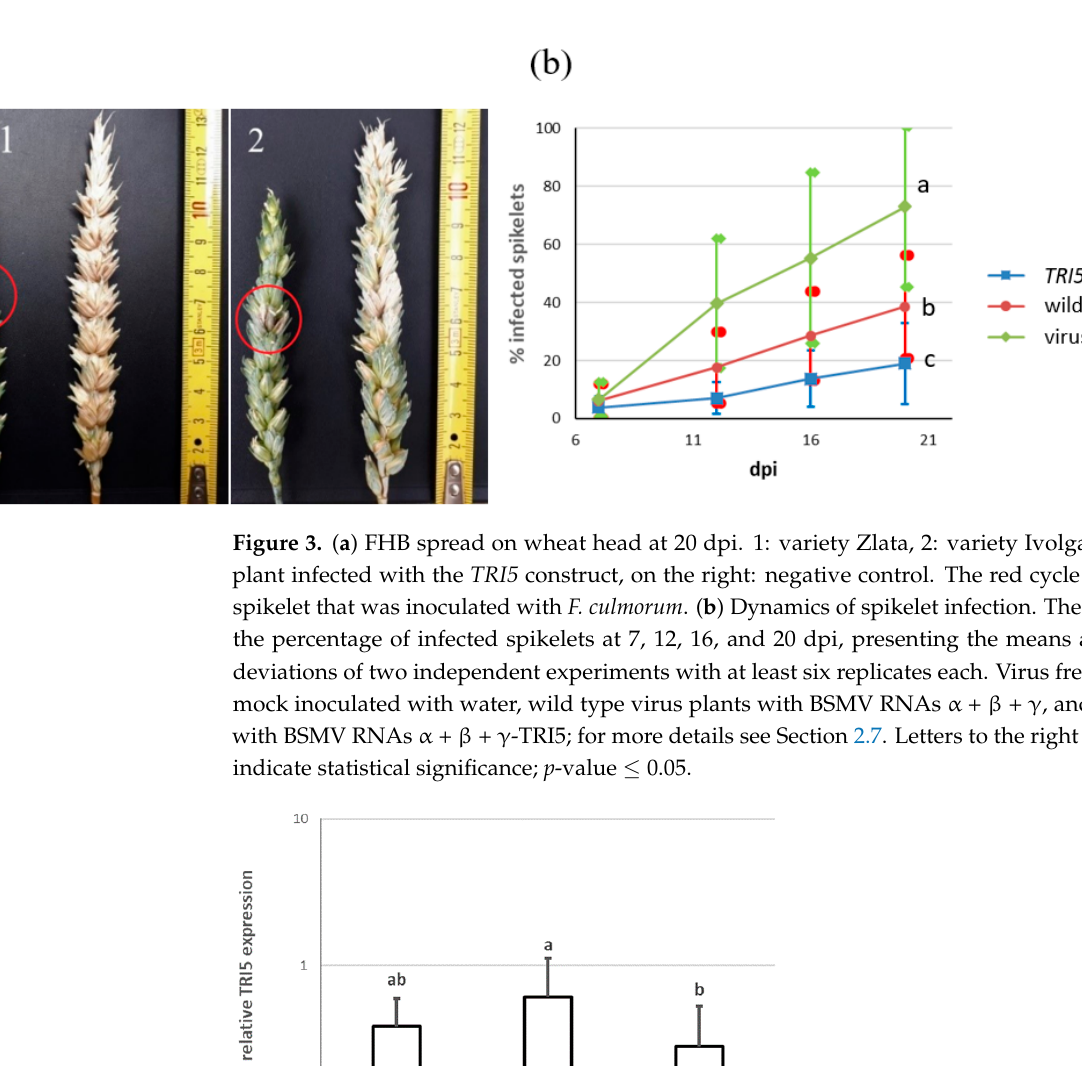
Figure 3. ( a ) FHB spread on wheat head at 20 dpi. 1: variety Zlata, 2: variety Ivolga. On the left: plant infected with the TRI5 construct, on the right: negative control. The red cycle indicates the spikelet that was inoculated with F. culmorum . ( b ) Dynamics of spikelet infection. The graph shows the percentage of infected spikelets at 7, 12, 16, and 20 dpi, presenting the means and standard de- viations of two independent experiments with at least six replicates each. Virus free plants were mock inoculated with water, wild type virus plants with BSMV RNAs α + β + γ , and TRI5 plants with BSMV RNAs α + β + γ -TRI5; for more details see 2.7. Letters to the right of the graphs indicate statistical significance; p -value ≤ 0.05.